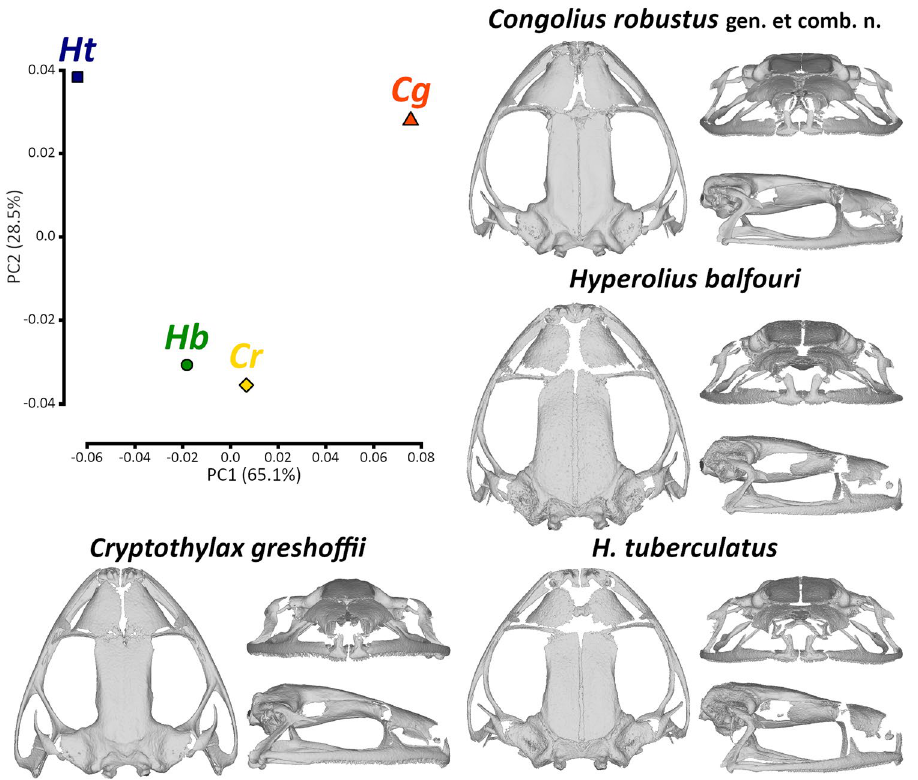
Figure 7. Cranial morphology and shapes in a morphospace of Congolius gen. n. and relative ( Cryptothylax ) or similar ( Hyperolius ) genera from the lowland Congo Basin. The morphospace is expressed by a principal component analysis of geometric morphometric landmarks. Cg ( Cryptothylax greshoffii , IVB-H-CD15-169, male), Cr ( Congolius robustus gen. et comb. n., ZMUC-R.771175, male), Hb ( Hyperolius balfouri , IVB- H-CD15-061, male), and Ht ( H. tuberculatus , IVB-H-CD15-010, male). Reconstructions in dorsal, frontal, and lateral views are based on high-resolution X-ray microcomputed tomography. Skull views are scaled to a similar size among the four taxa. See Supplementary Fig. S4 for comparison of all scanned